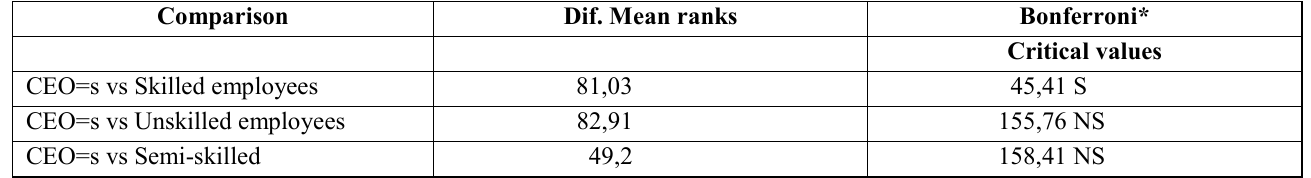
Table 3: Paired comparison for the difference between employee levels on task/people orientation